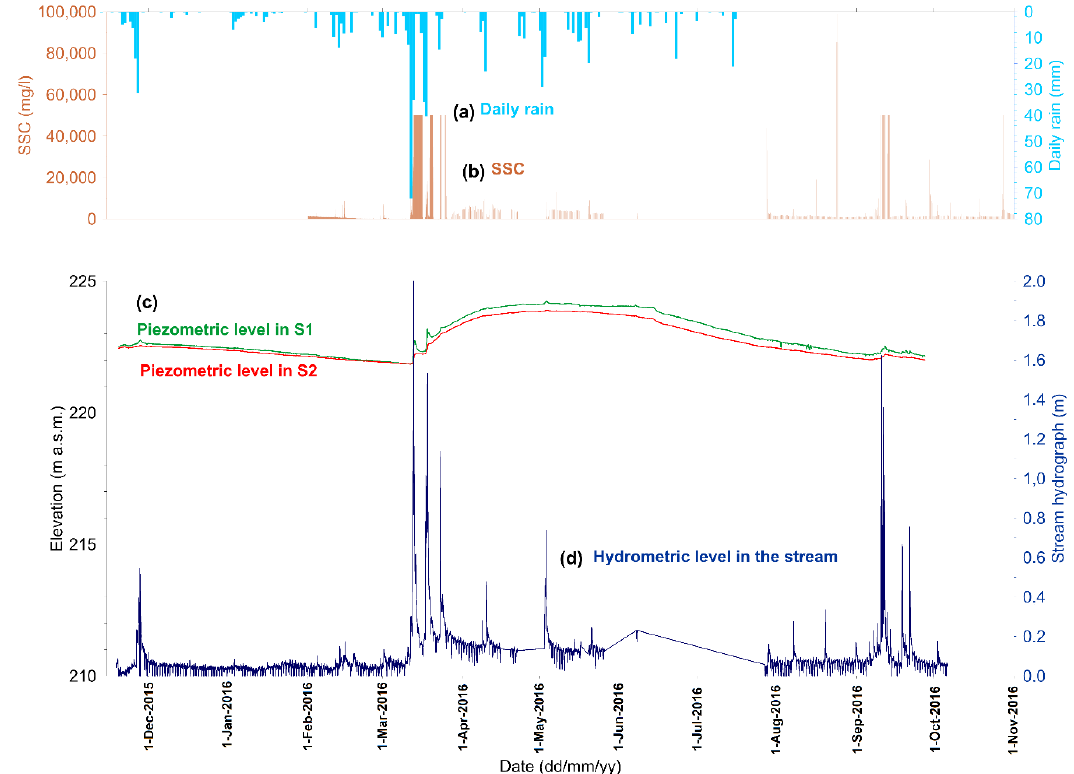
Figure 11. Time series of the groundwater level in the boreholes S1 and S2 ( c ), compared with the water level in the stream ( d ), the daily rain amount ( a ) and the suspended sediment concentration ( b